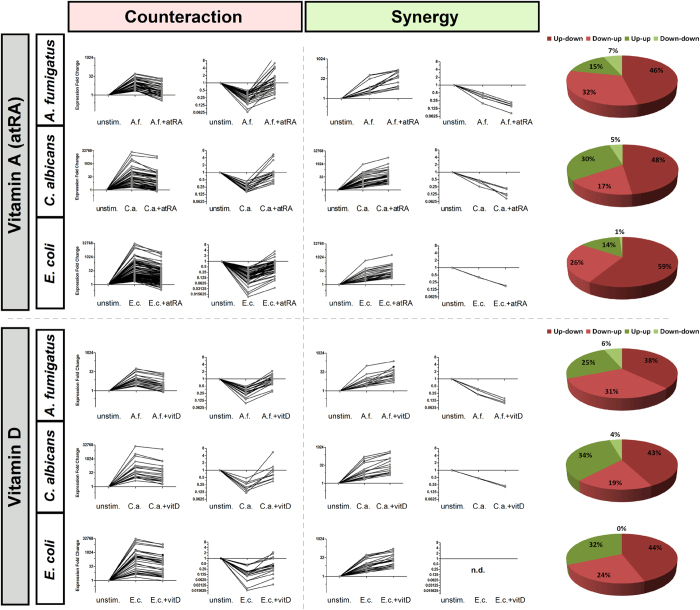
Vitamins A and D strongly counteract the transcriptional response of human monocytes to pathogens.Graphic representation of the expression dynamic of immune-relevant genes (GO:0002376) differentially regulated by both the pathogens and the vitamins. Patterns are divided by the type of correlation observed between the effects of pathogen and vitamin stimulations: counteractive effect (up-regulation by pathogen and down-regulation by vitamin, or vice versa) and synergistic effect (same direction observed in the differential expression induced by pathogen and vitamin stimulations). Pie charts show the proportion of genes depicting counteractive effects (red) and synergistic effects (green).